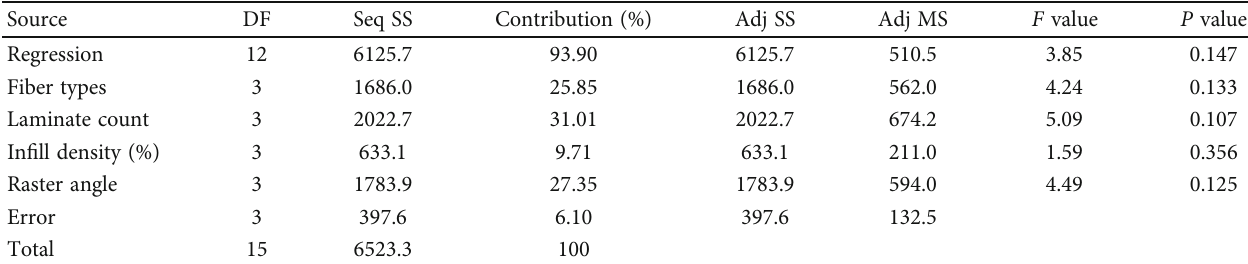
Table 9: Analysis of variance of shore